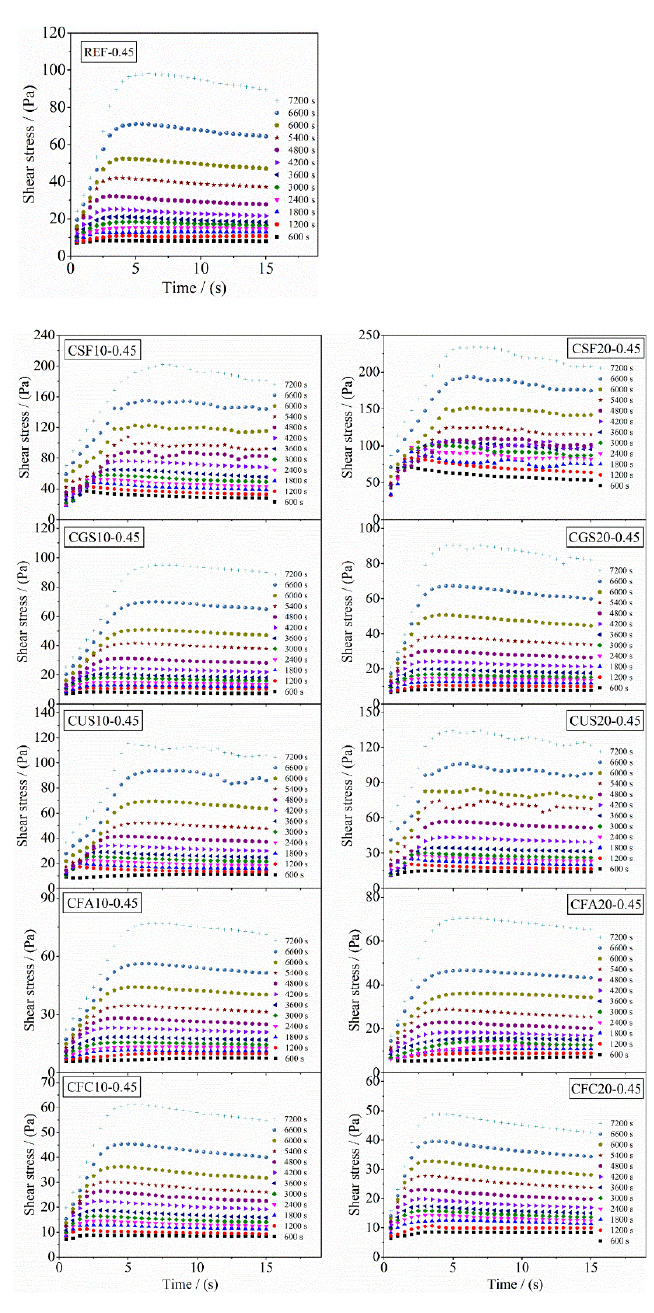
Figure 5. The change of shear stress of common pastes with time at each test stage.